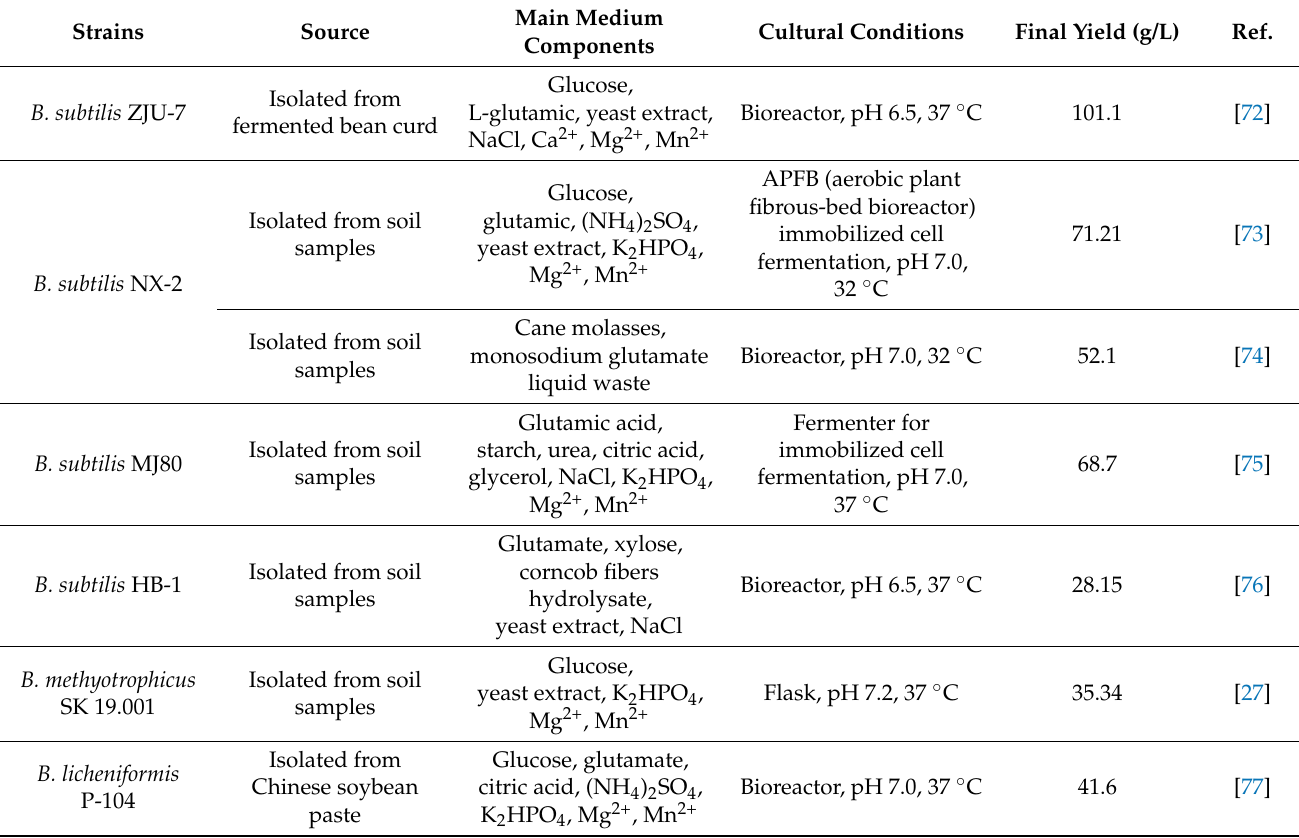
Table 1. Sources of γ -PGA production trains.